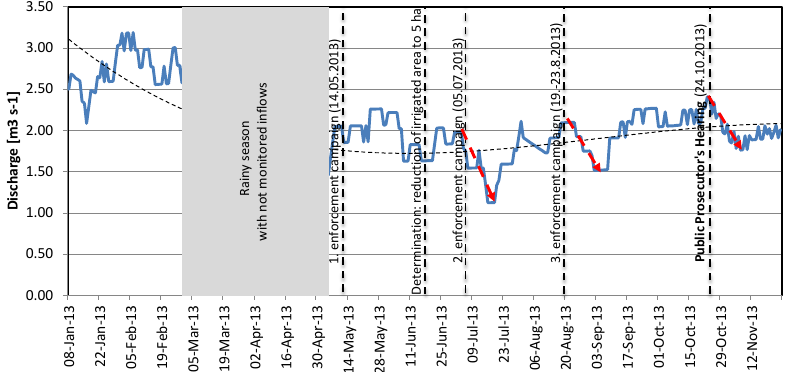
Figure 5. Relationship between reservoir water withdrawal for consumption from Epitácio Pessoa reservoir and enforcement campaigns.